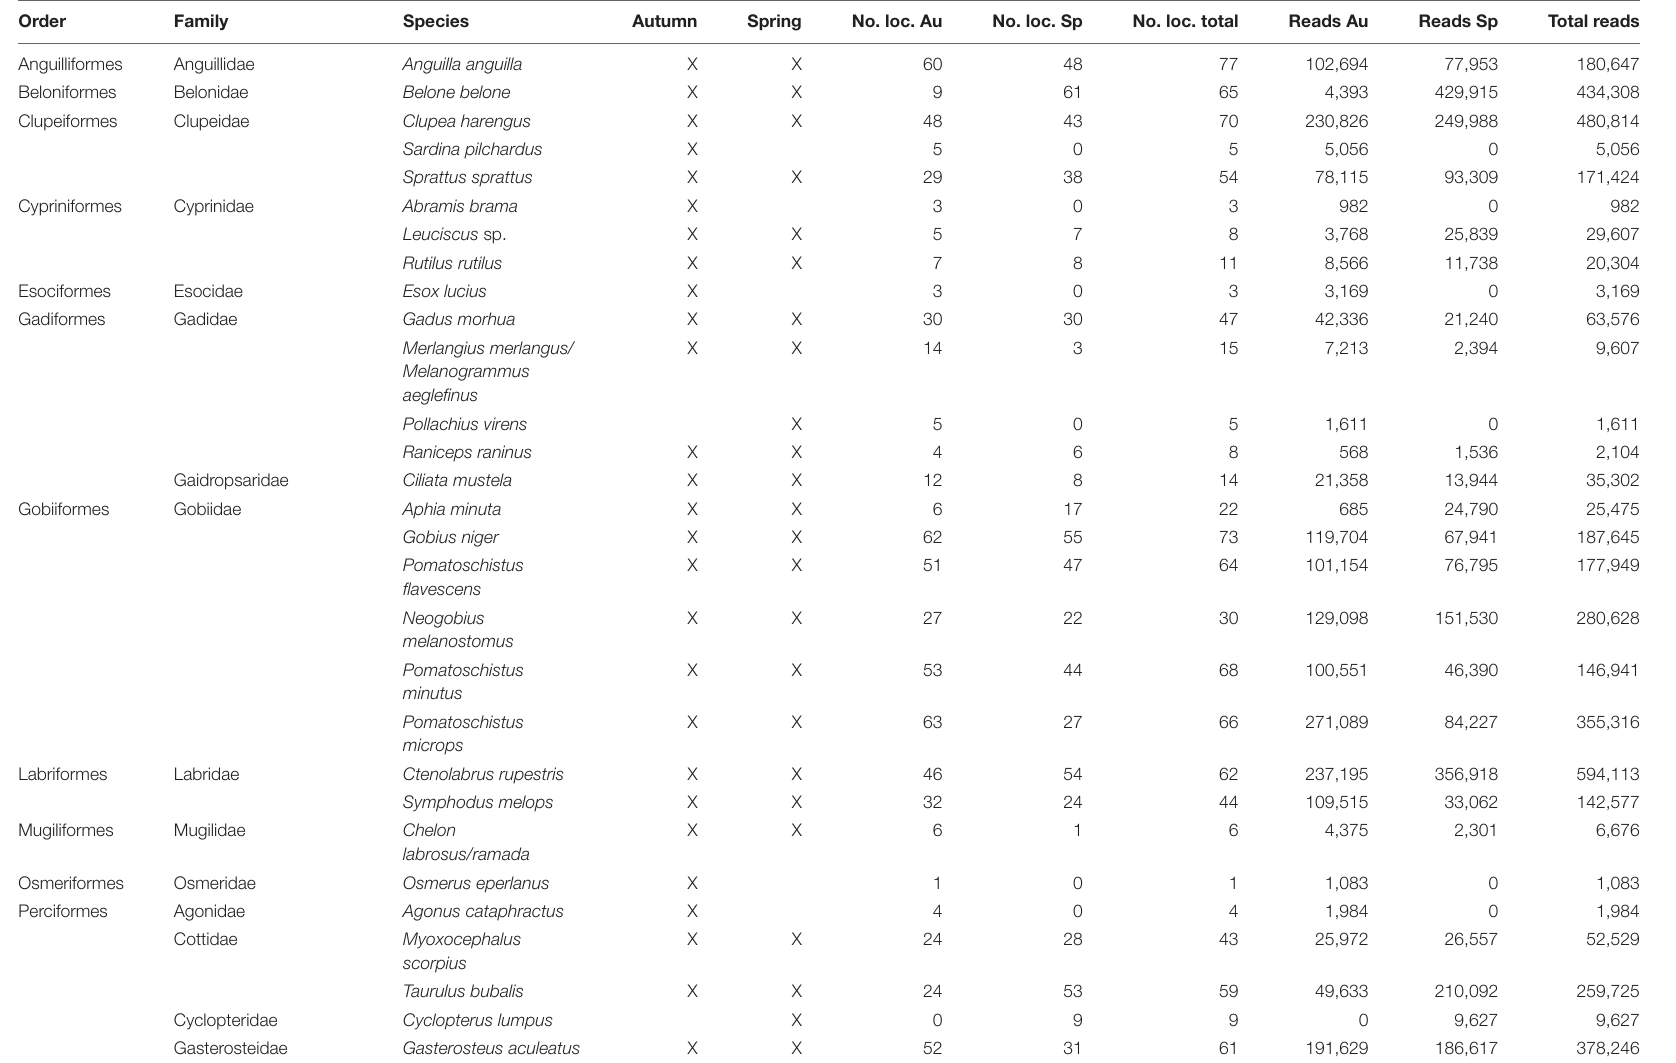
TABLE 1 | Overview of seasonal presence and sequence abundance in both autumn and spring of all fish taxa identified.